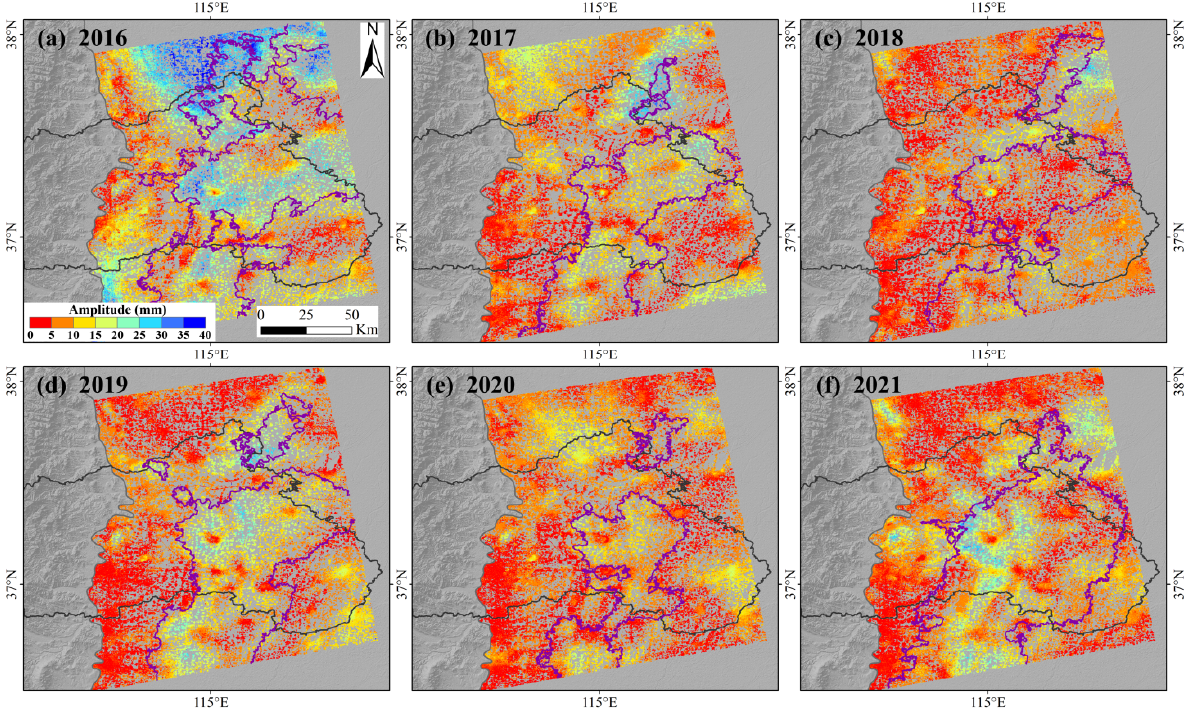
Figure 7. The amplitude of seasonal deformation across the Xingtai plain in ( a – f ) 2016~2021.The purple lines mark the contours of a subsidence rate of 60 mm/a.